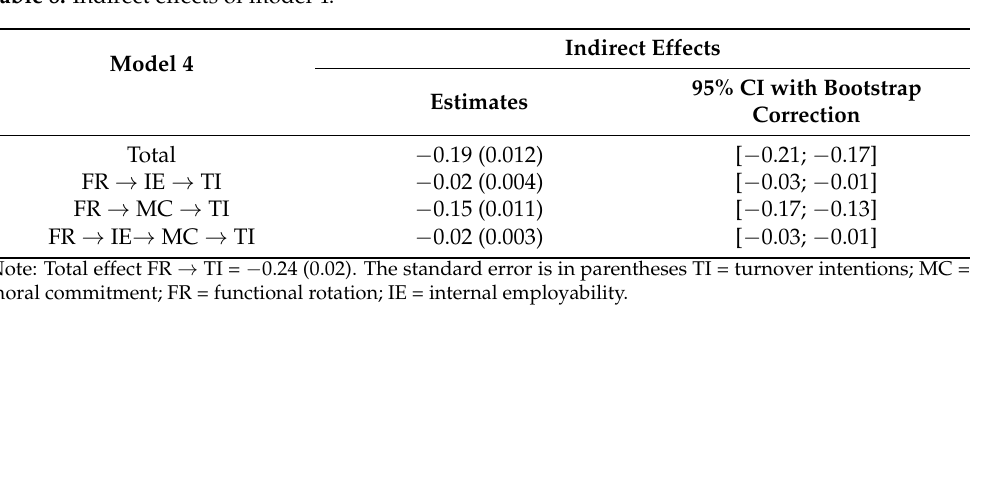
Figure 5. Model 4. Note. ** p < 0.01. Table 8. Indirect effects of model 4. Model 4